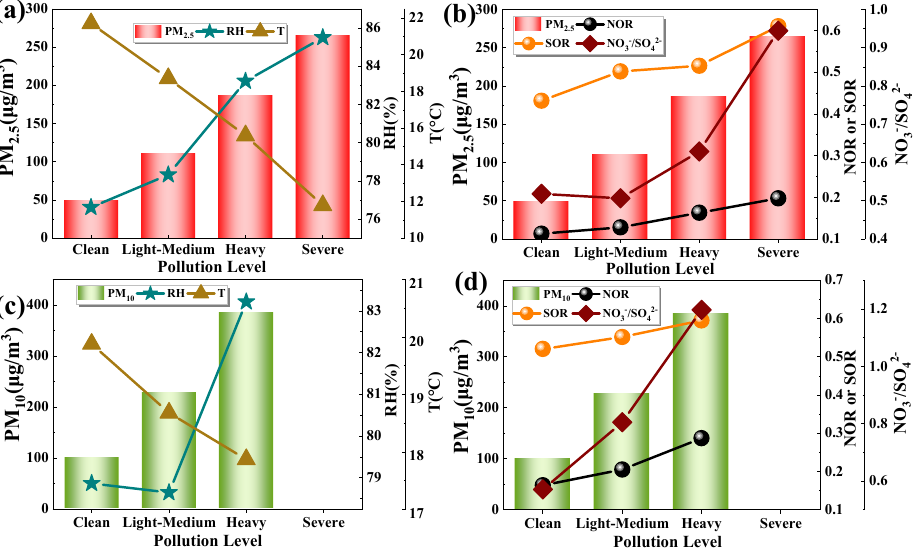
Figure 6. Changes of ( a ) RH, T, PM 2.5 ; ( b )SOR, NOR, NO 3 − /SO 42 − , and PM 2.5 ; ( c ) RH, T, PM 10 ; ( d ) SOR, NOR, NO 3 − /SO 42 − and PM 10 at different pollution levels (RH: relative humidity; SOR/NOR: sulfur/nitrogen oxidation rate; T: temperature).